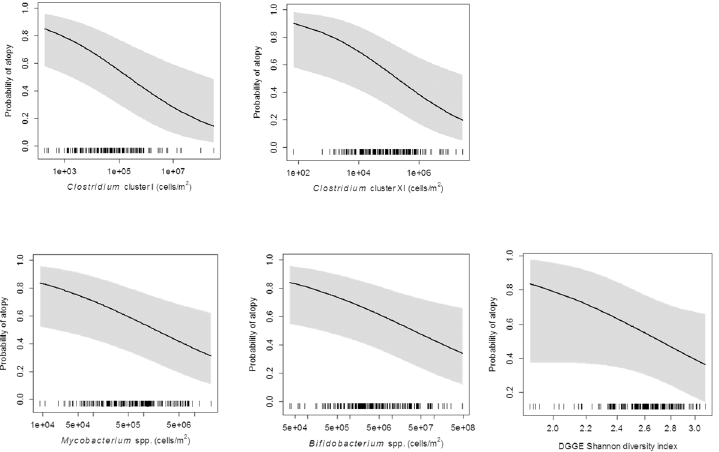
Fig 2. Logistic regression analyses for microbial determinations and atopy. Survey weighted logistic regression analyses fitted with a cubic spline term for qPCR results (in cells/m2 dust) in mattress dust and probability of atopy (0.7kU/L) in the whole study population. 95% confidence intervals displayed as shaded bands. One extremely small value (outlier) for the Shannon diversity index (0.68) was